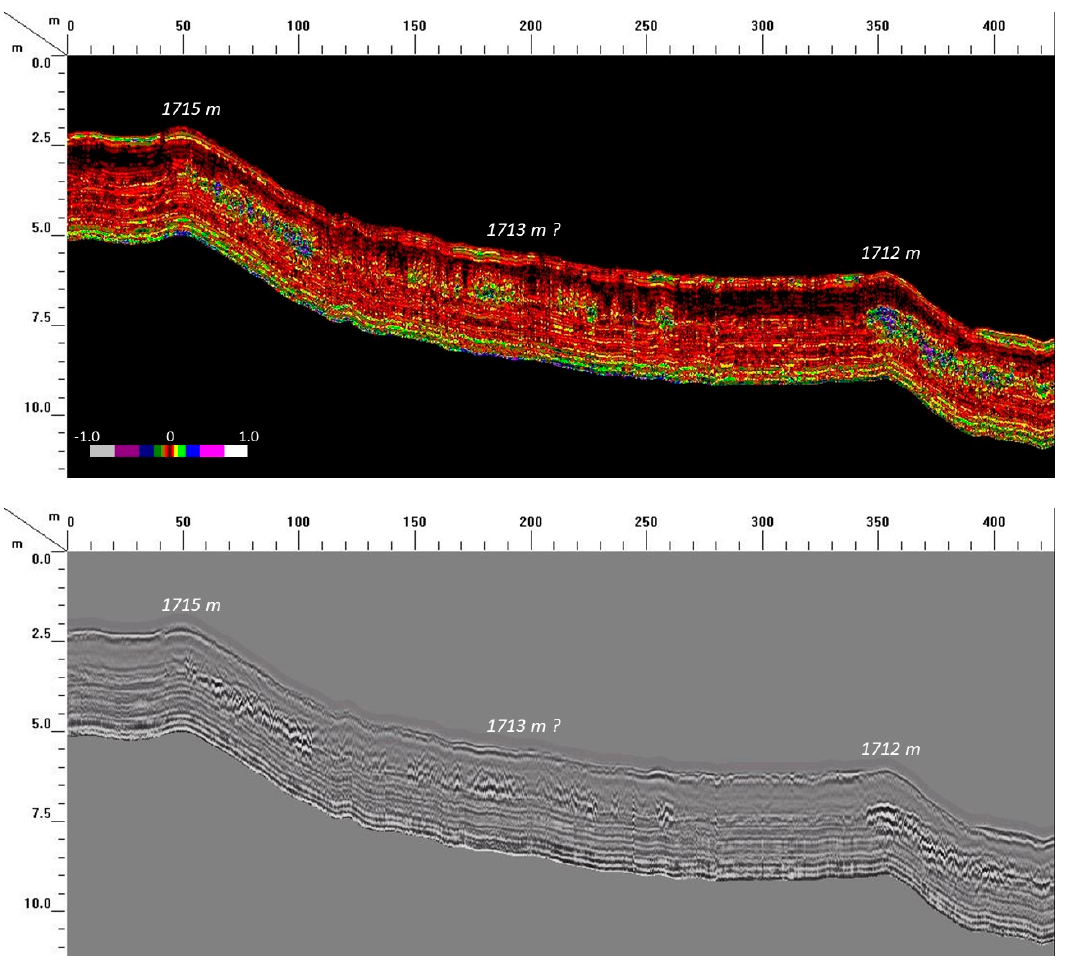
Figure 13. GPR profile for Transect C crossing the lowest shorelines of Lake Clover, labeled with their elevations in meters above sea level. In the upper transect, data are presented with a color scale to highlight the normalized intensity of radar reflectors. The lower profile presents the same data in grayscale. In both profiles, landward is to the left and lakeward is to the right. Enlargements and interpretations of the GPR data centered on each shoreline are presented in Figures 14 and 15. Vertical exaggeration 15×.